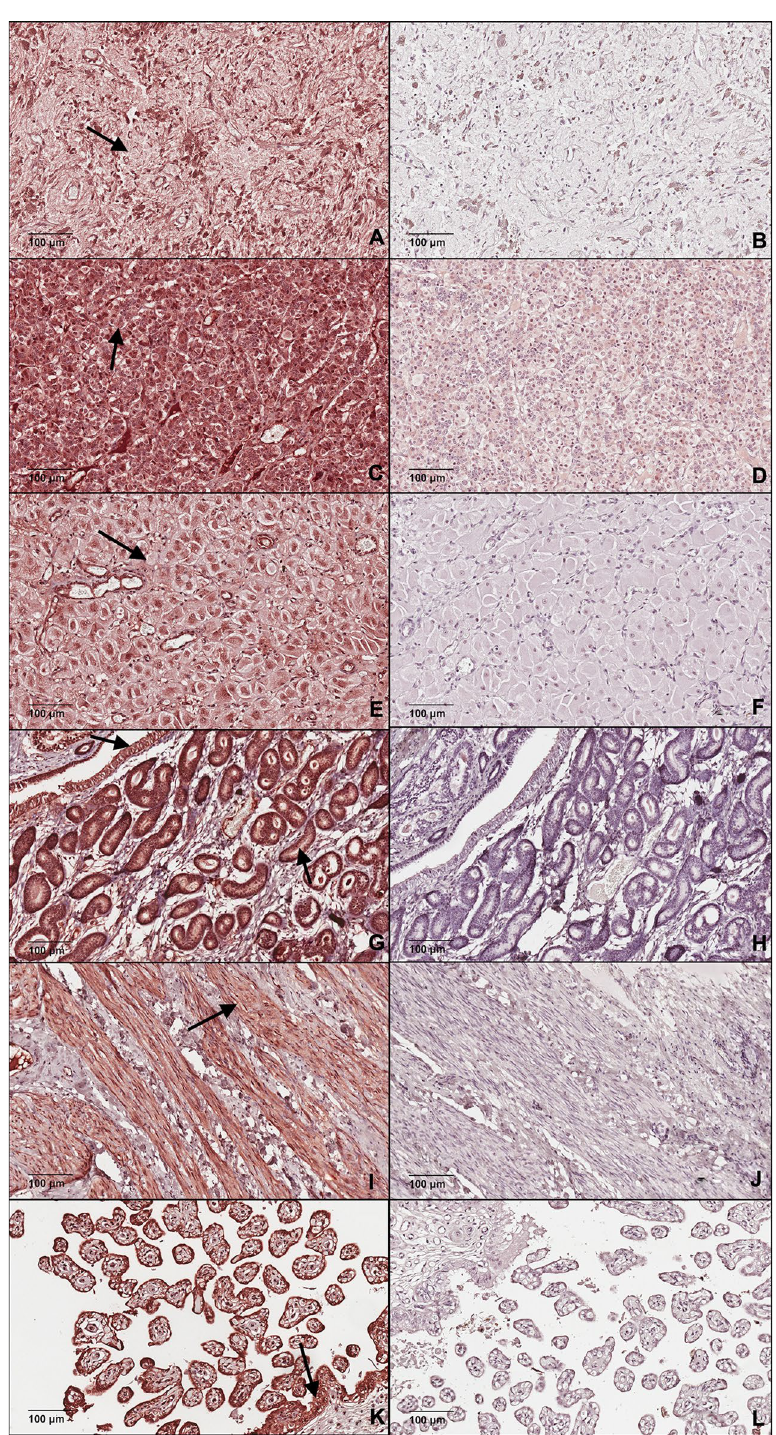
Figure 4. Photomicrograph demonstrating immunolocalization of LNPEP in: ( A ) posterior hypophysis, ( C ) anterior hypophysis, ( E ) corpus luteum, ( G ) endometrium, ( I ) myometrium and ( K ) placenta. Black arrow shows cytoplasmatic specific staining. Negative epitope controls for each tissue ( B , D , F , H , J and L